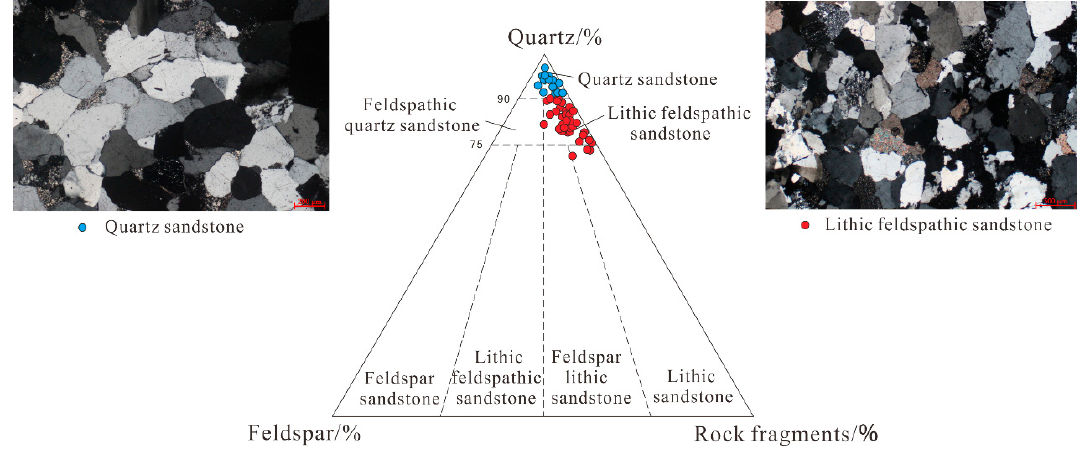
Figure 3. Ternary diagram of lithology.